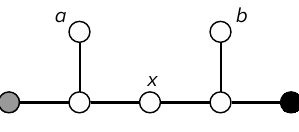
Fig. 10: Diagram showing T 1 . The colors c ( u ) and c ( v ) aren’t necessarily